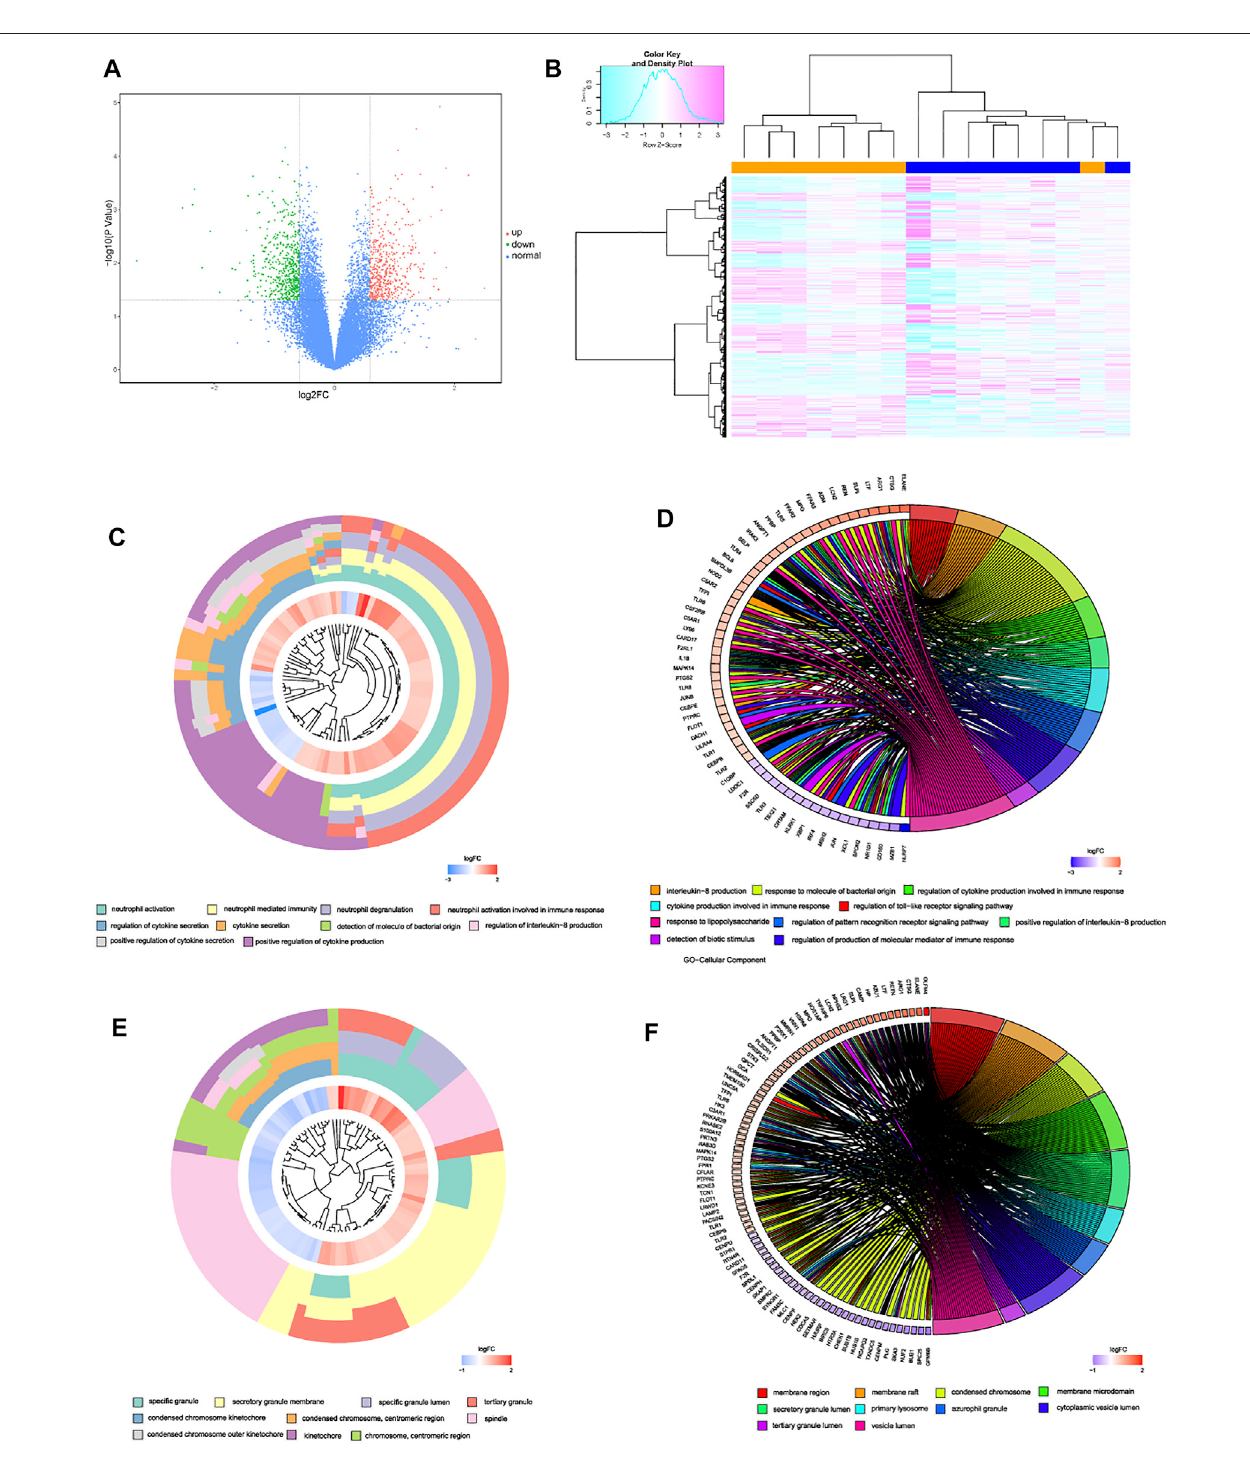
FIGURE 1 | (A) volcano plot of DEGs, red dots represented up-regulated genes, green dots represented down-regulated genes, and black dots represented normalgenes. (B) heatmapofDEGsinGSE124272. (C – F) enrichmentclusterplotandchordplotofBPsandMFsfromGOanalysis,the fi rst10termswereillustratedas enrichment cluster plot, and the next 10 terms were illustrated as chord plot.